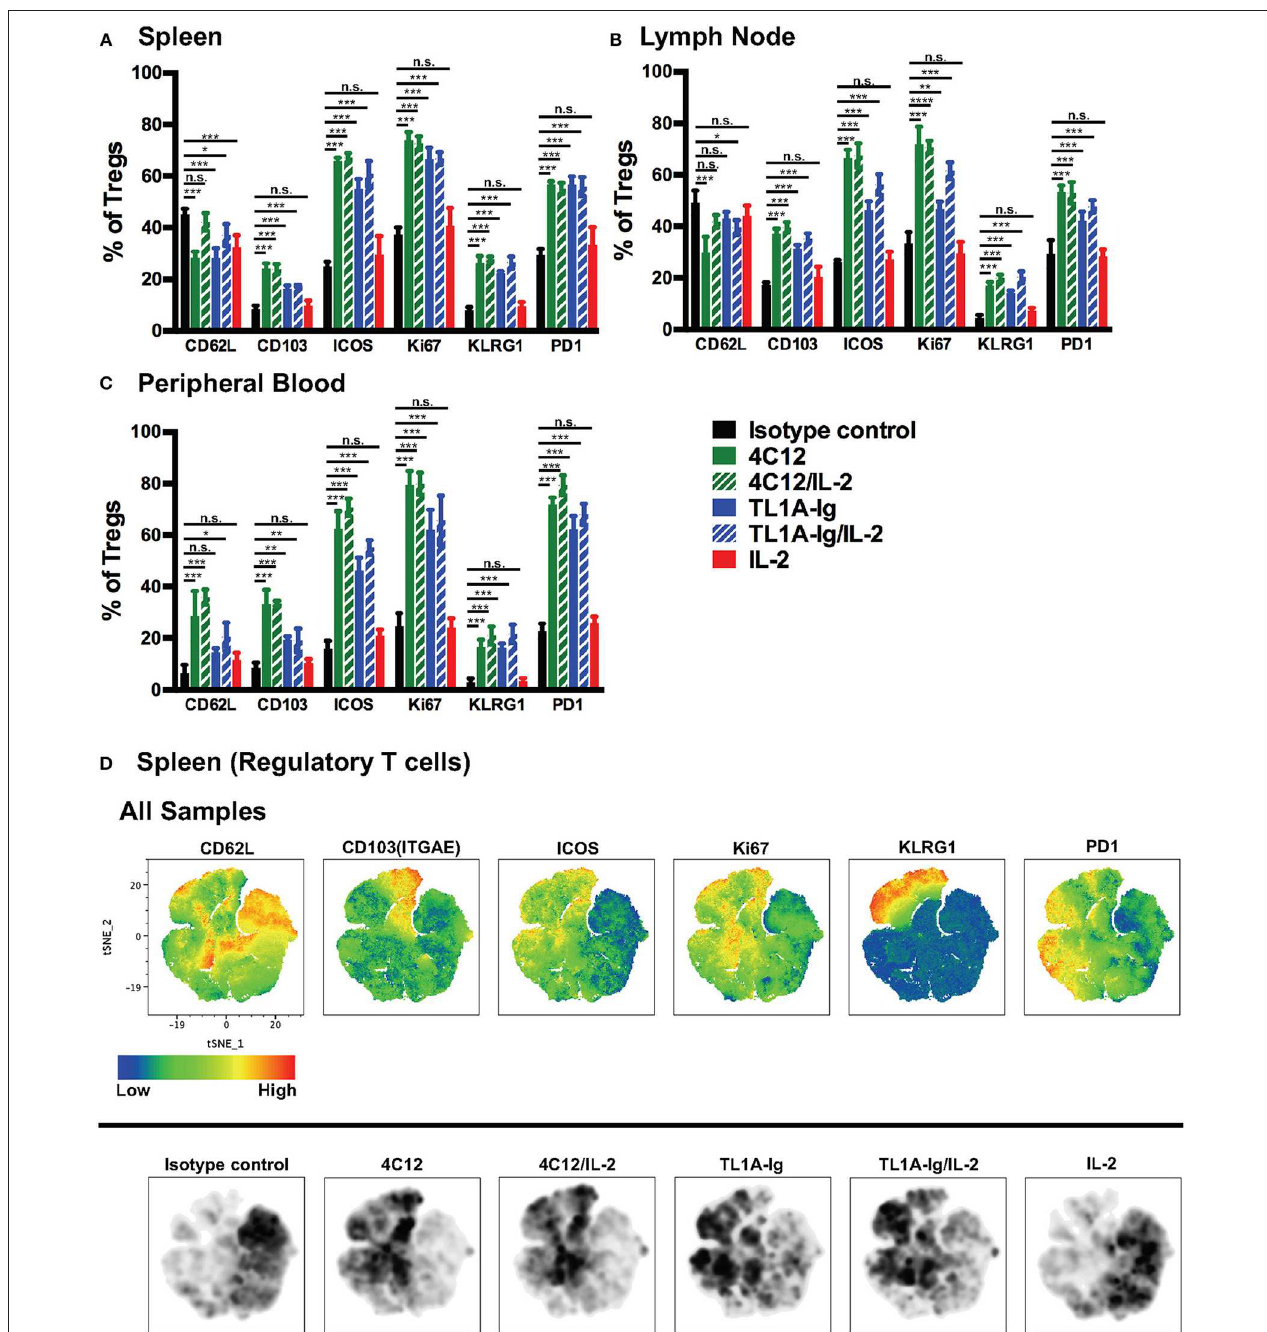
FIGURE 4 | In vivo stimulation of death receptor 3 leads to activation of expanding regulatory T cells. Tissues were isolated from mice treated as in Materials and Methods on day 7 of the treatment regimen, single cell suspensions prepared, and cells were analyzed by flow cytometry. Shown are the expression levels of activation makers in FoxP3 + regulatory T cells from (A) spleen, (B) lymph nodes, and (C) peripheral blood. (Shown are the mean and SD for each group ( n = 4). n.s., not significant; * p < 0.05, ** p < 0.01, and *** p < 0.001 as compared to isotype control antibody treatment, one-way ANOVA with Bonferroni correction for multiple comparisons). Data shown are representative of 2 independent experiments. (D) Splenic FoxP3 + Treg were gated from live lymphocytes, concatenated from all samples, and subjected to tSNE analysis. Upper panels show heat maps of all concatenated samples for the indicated analytes. Lower panels show density plots for each treatment group ( n = 4) on the same tSNE map, with darker areas indicating more cells present in that region.